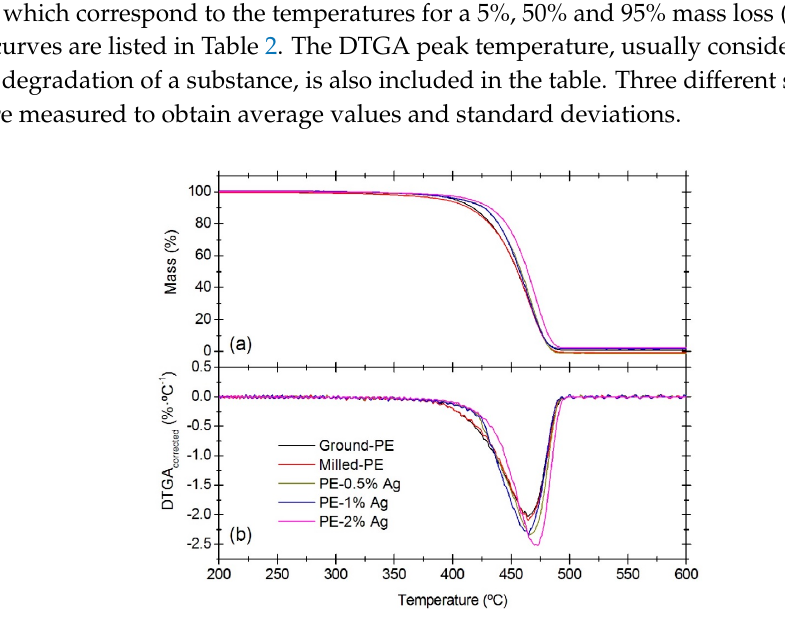
Figure 3. Characteristic TGA curves ( a ) and DTGA curves ( b ) of LDPE and LDPE/Ag nanocomposites.